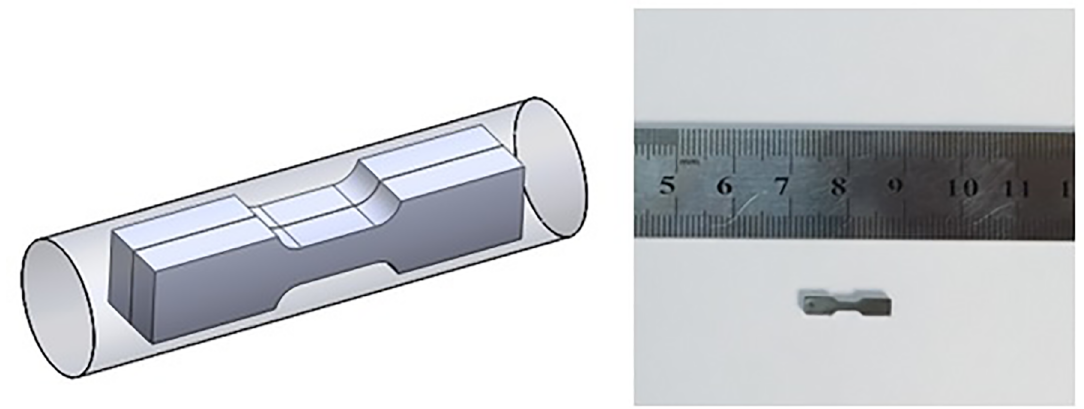
Figure 2. The experimental